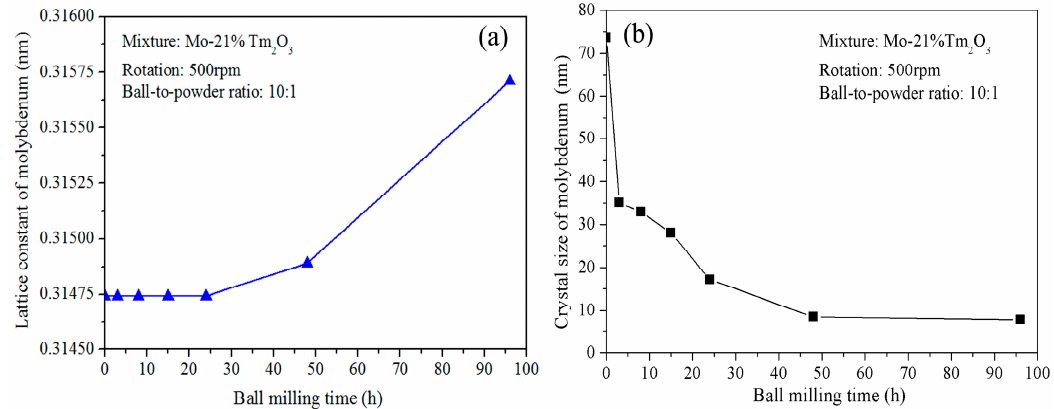
Figure 2. ( a ) Curve of the lattice parameter of Mo vs. ball-milling time; and ( b ) curve of the crystalline size of Mo vs. ball-milling